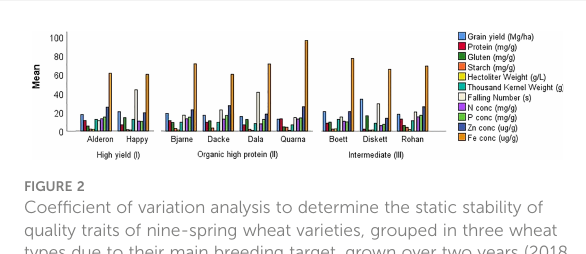
FIGURE 2 Coef fi cient of variation analysis to determine the static stability of quality traits of nine-spring wheat varieties, grouped in three wheat types due to their main breeding target, grown over two years (2018 and 2019) in a fi eld experiment in Uppsala, Sweden. Genotypes Alderon and Happy are categorized as High yield wheat type (I); Bjarne, Dacke, Dala, and Quarna are categorized as Organic high protein wheat type (II), and Boett, Diskett, and Rohan are categorized as Intermediate wheat type